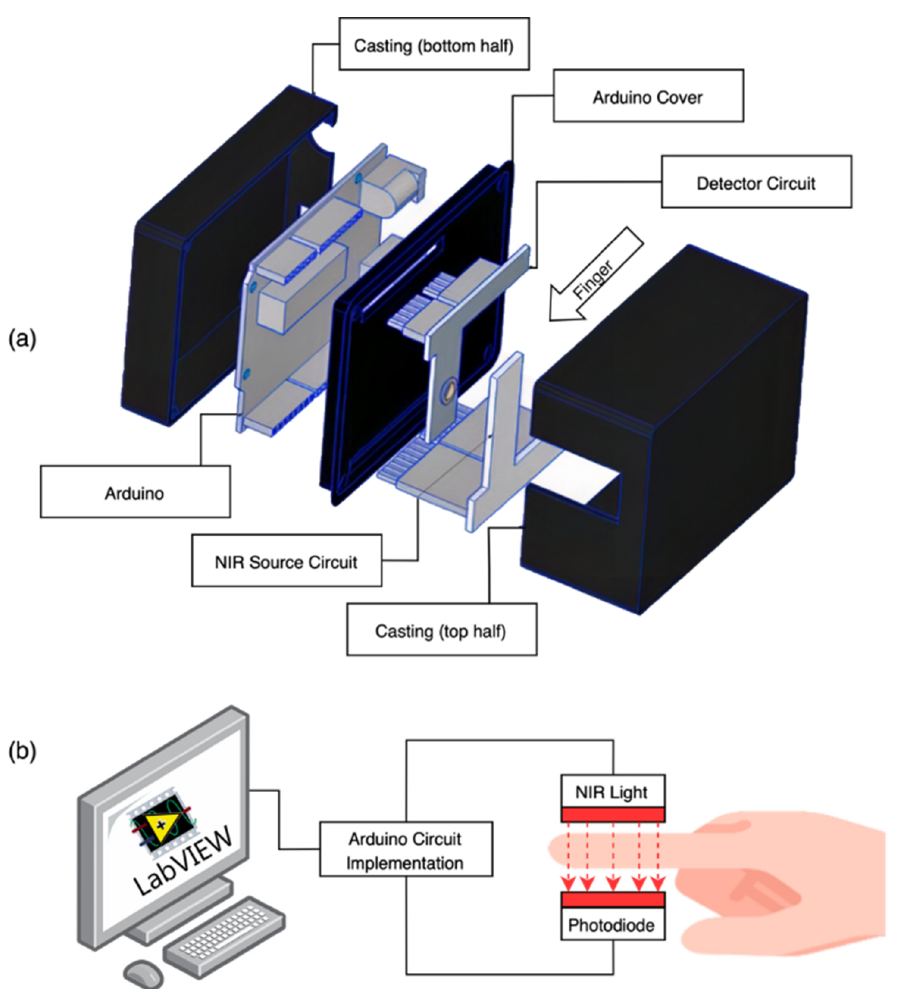
Figure 4. ( a ) A prototype for the NIR transmission spectroscopy for the noninvasive glucose moni- toring system and ( b ) the finger placement illustration. In this prototype, only transmitted photons via the finger are measured. Reproduced with permission from [24].